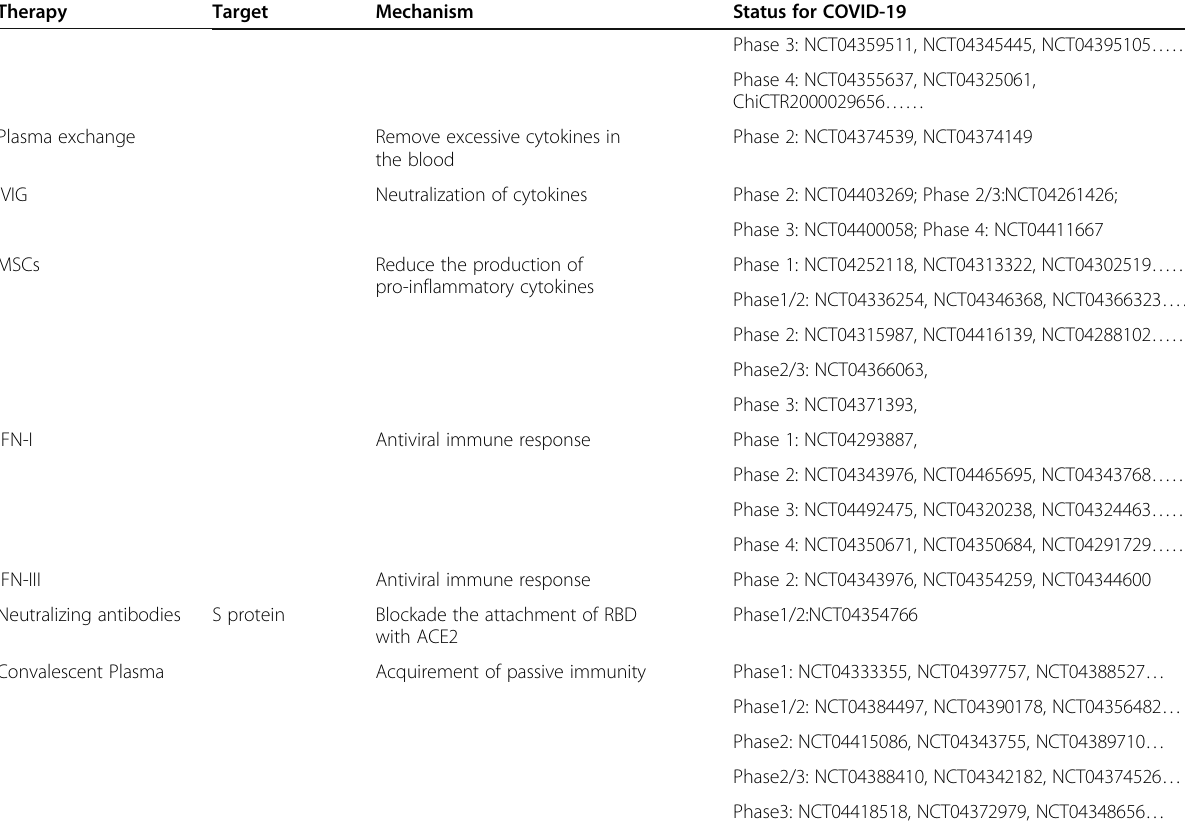
Table 2 Ongoing clinical trials of immune-related therapies for COVID-19 (Continued)